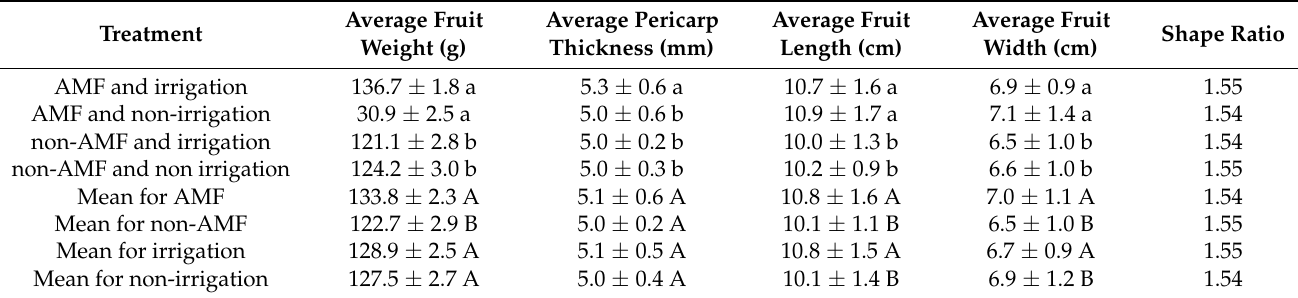
Table 2. Quality parameters of bell pepper fruits grown with or without mycorrhizal inoculation and irrigation (mean for